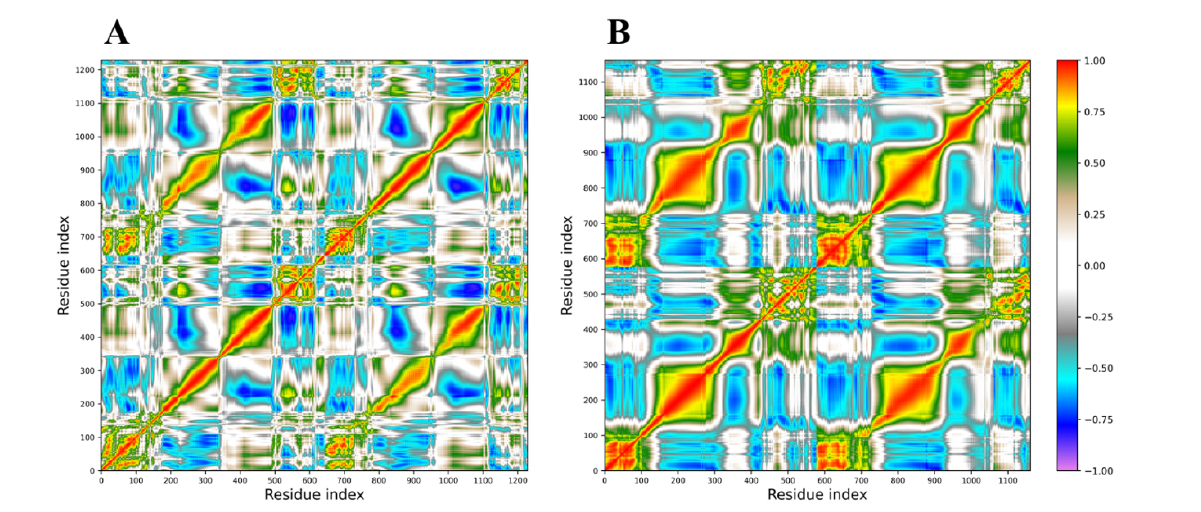
Figure 9. Dynamic cross-correlation matrices obtained from PCA analysis of the ( A ) WT (black line) and ( B ) ∆ K1/K10 (red line) dimers trajectories. Positive correlations are identified by colors ranging from light brown to red, while negative correlations are described by colors ranging from grey to